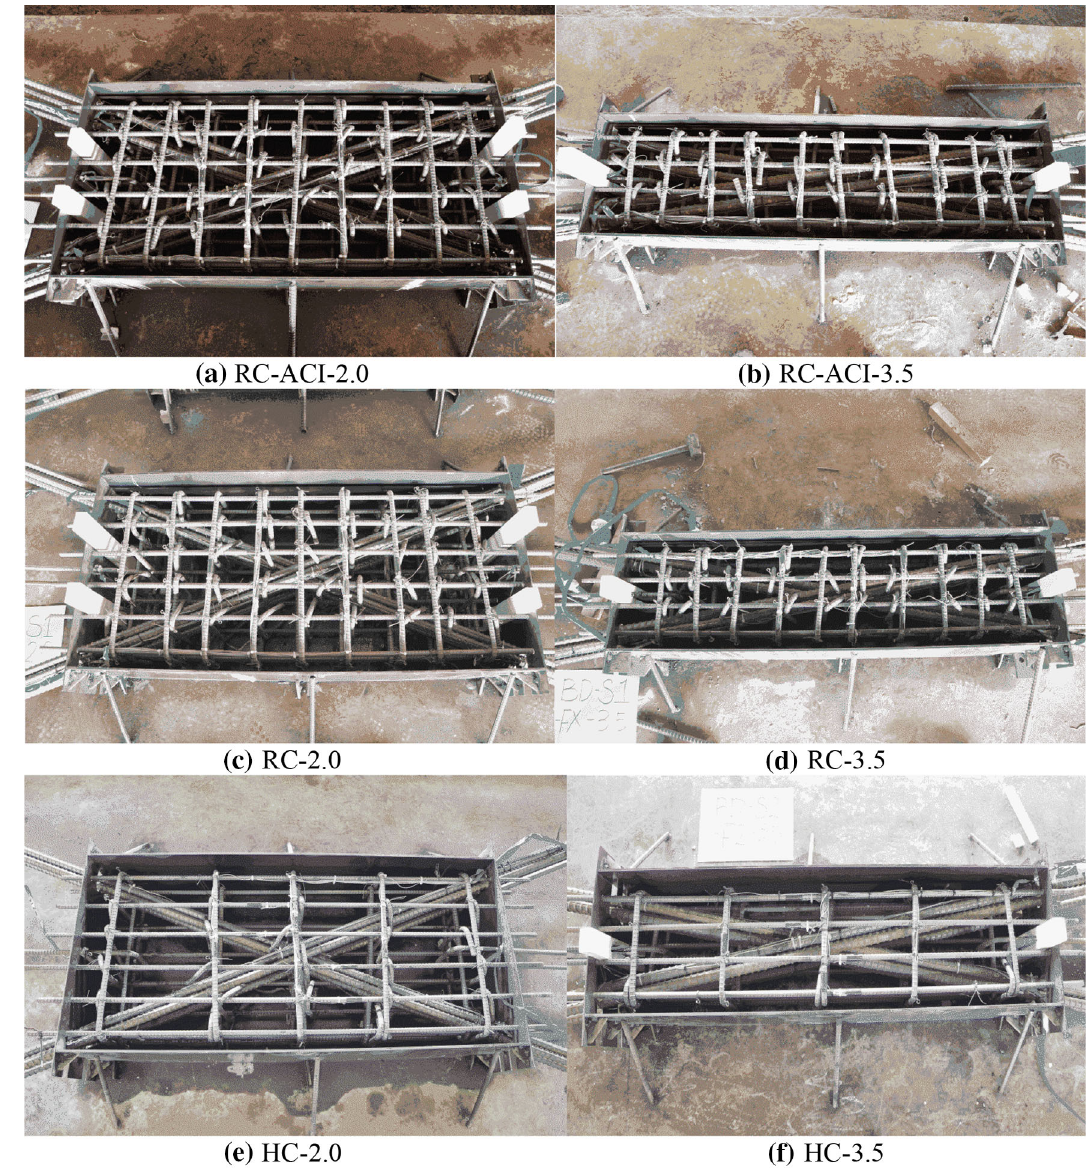
Fig. 3 Reinforcement cages inside coupling beam